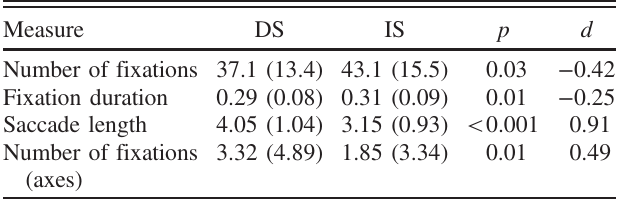
TABLE III. Comparison of different eye-tracking measures (mean and standard deviation) between both strategies (in both test periods). The meaning of the p values is the usual statistical significance level, i.e. the greater p , the higher the probability that the differences between the means were found due to chance. The magnitude of the difference is quantified by Cohen ’ s d , a standard effect size measure.